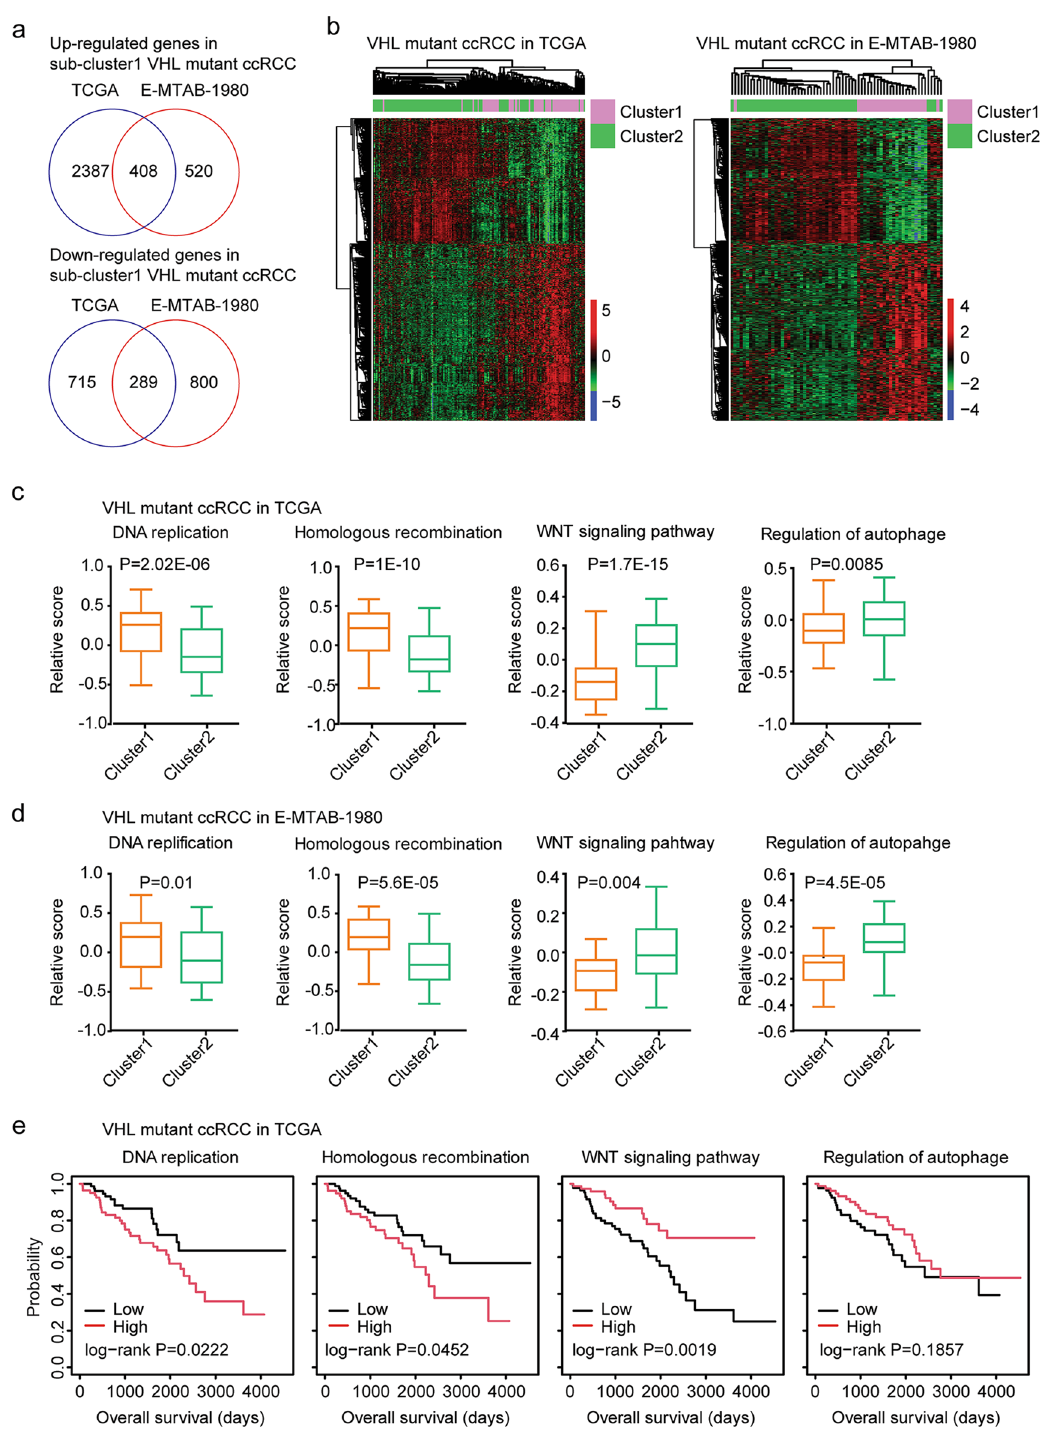
Figure 2. Transcriptional characteristics of the different sub-clusters of VHL mutant ccRCC. ( a ) The overlapped up-regulated or down-regulated genes in sub-cluster1 VHL mutant ccRCC patients in TCGA and E-MTAB-1980 datasets. ( b ) Heatmaps demonstrated the overlapped differentially expressed genes in sub-cluster1 VHL mutant ccRCC patients in TCGA and E-MTAB-1980 datasets. ( c ) The scores of signaling pathways in sub-cluster1 and sub-cluster2 VHL mutant ccRCC patients in TCGA dataset. ( d ) The scores of signaling pathways in sub-cluster1 and sub-cluster2 VHL mutant ccRCC patients in E-MTAB-1980 dataset. ( e ) Kaplan–Meier Plotters showed the correlations of the signaling pathways and the overall survival of VHL mutant ccRCC patients in TCGA